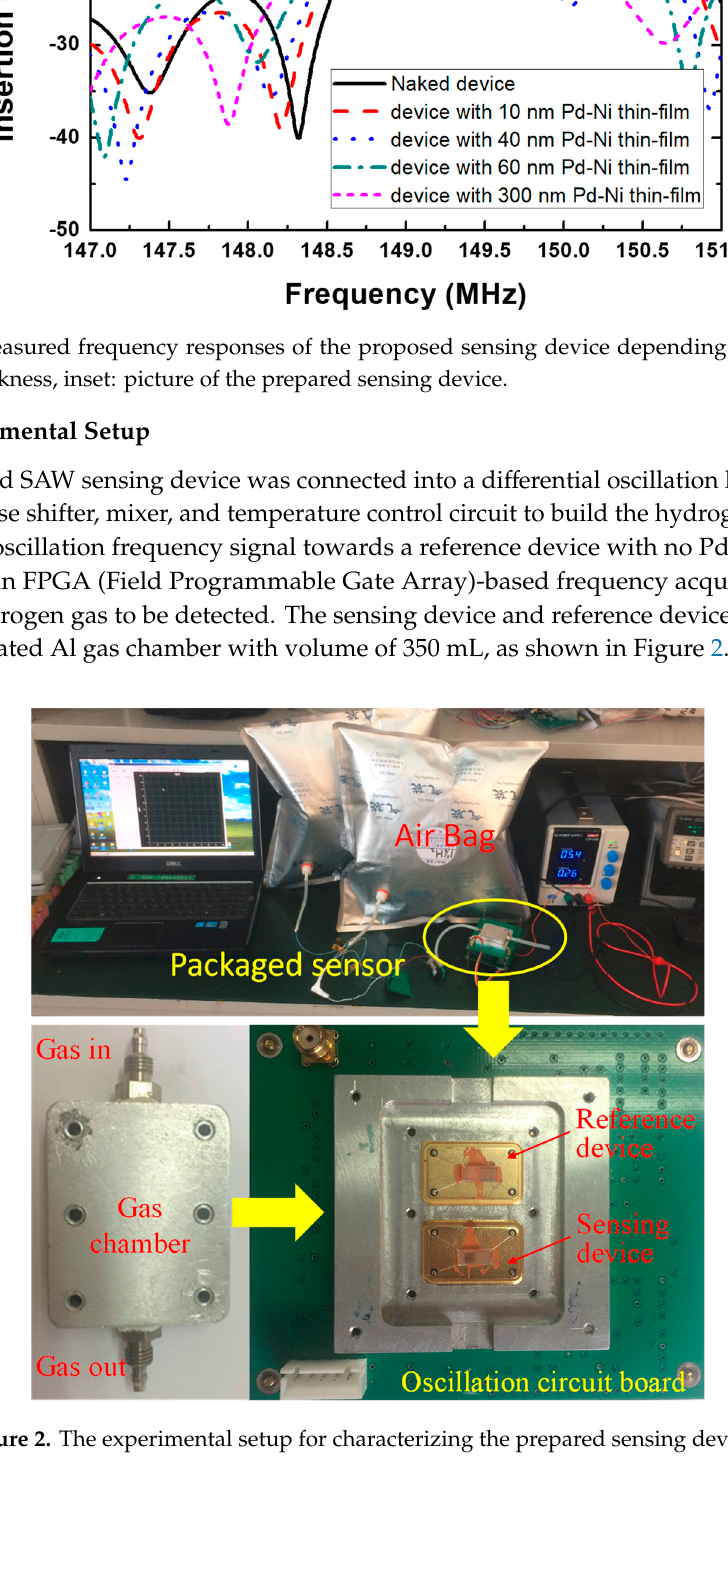
Figure 3. The measured baseline noise of the sensor system. 4. Sensor Performance Evaluation Using the experimental setup described in Figure 2, the prepared Pd-Ni alloy thin-film coated sensing devices were characterized, and corresponding sensor performance metrics such as sensitivity, repeatability, detection limit, and working stability were evaluated. Especially, the effect of Pd-Ni alloy thin-film thickness on sensor performance was conducted to extract the optimal parameters. 4.1. Repeatability First, the repeatability of the 10 nm Pd-Ni alloy thin-film coated sensing device was evaluated by checking the sensor response from five consecutive 50 s on–off exposures to 0.1% hydrogen in 0